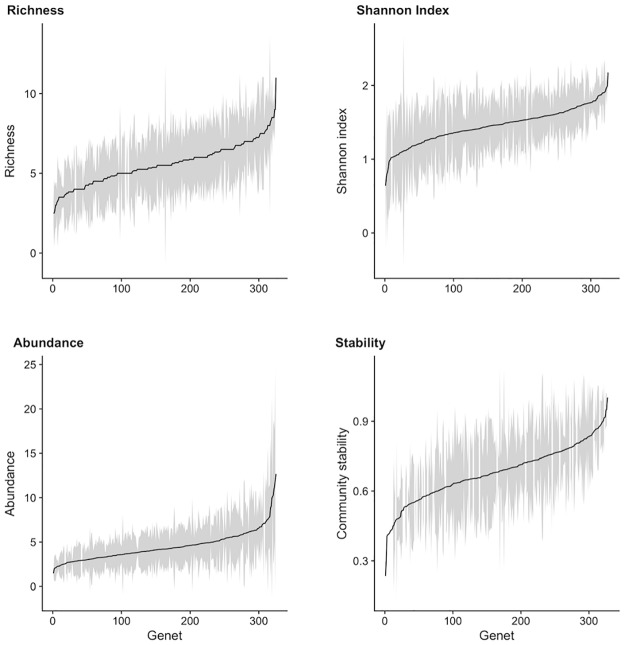
Bar plots of insect community metric variation.Variation in insect community metrics (species richness, Shannon Index, total abundance, and community stability) across aspen genets at WisAsp in 2014 and 2015. Each black point is the average value across years and tree replicates, and the gray shading represents the standard deviation. All plots are ordered from low to high genet values, and the y-axes are presented with different scales.